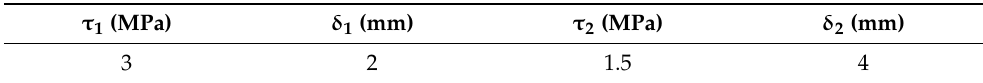
Table 2. Properties of the boundary surface.